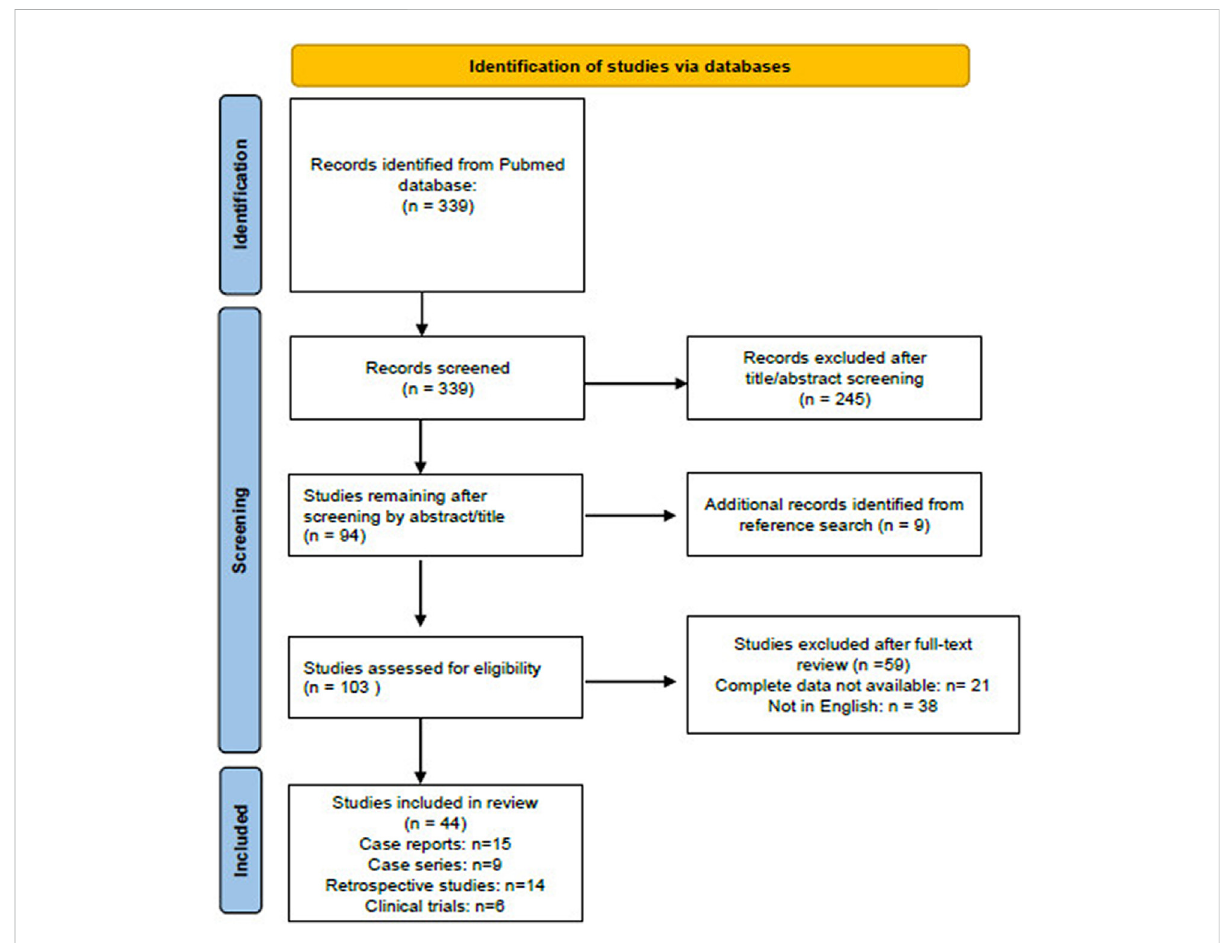
FIGURE 1 Flow diagram of the literature screened using the Preferred Reporting Items for Systematic Reviews and Meta-Analyses (PRISMA) guidelines. The fi gure is adapted from